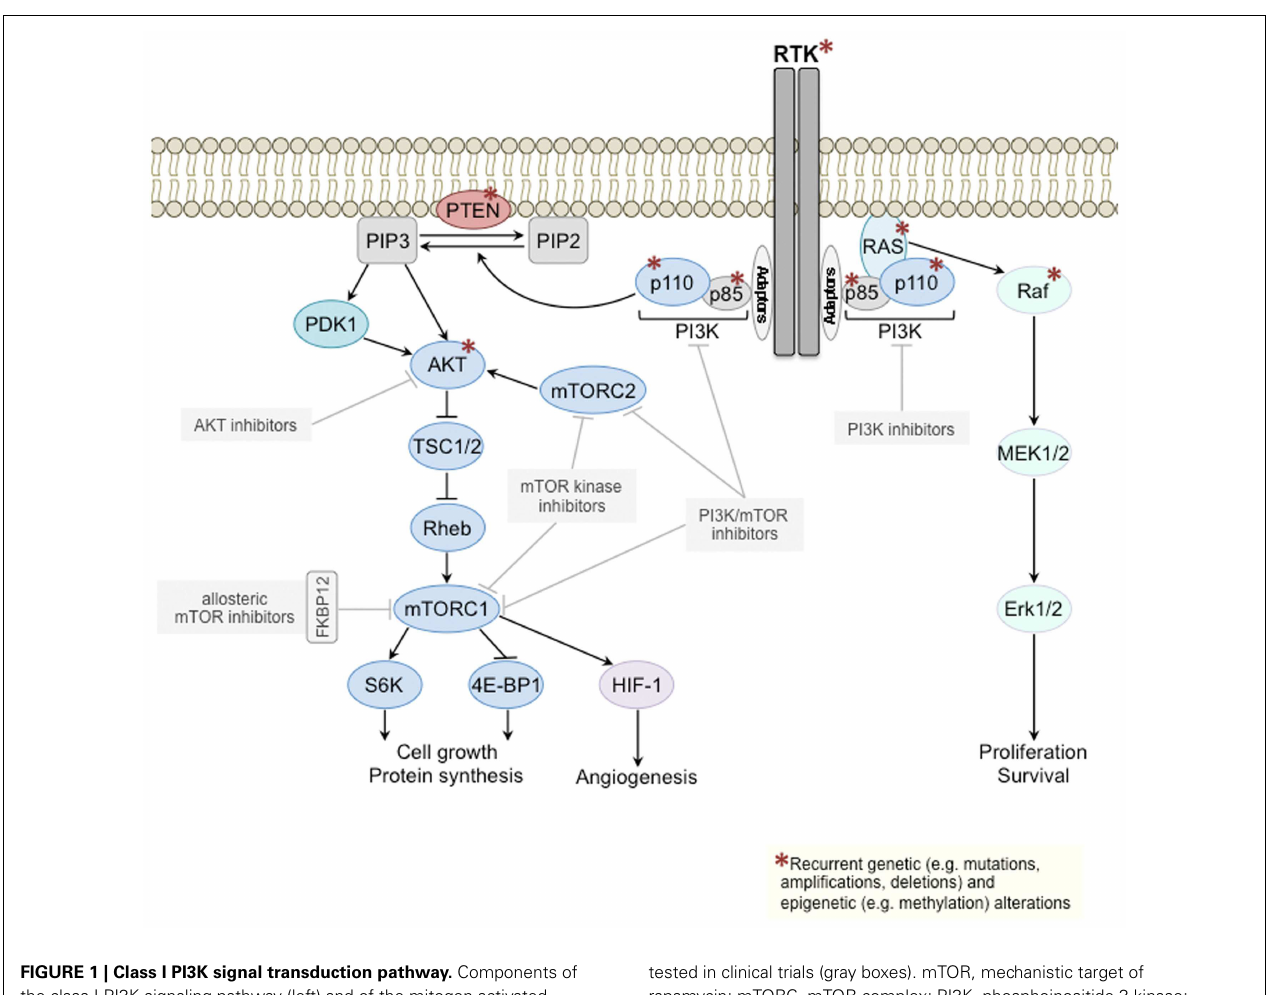
FIGURE 1 | Class I PI3K signal transduction pathway. Components of the class I PI3K signaling pathway (left) and of the mitogen-activated protein kinase (MAPK) pathway (right) recurrently targeted by genetic/epigenetic alterations in cancer are depicted with a red asterisk. Several PI3K pathway inhibitors downstream of RTKs are currently being